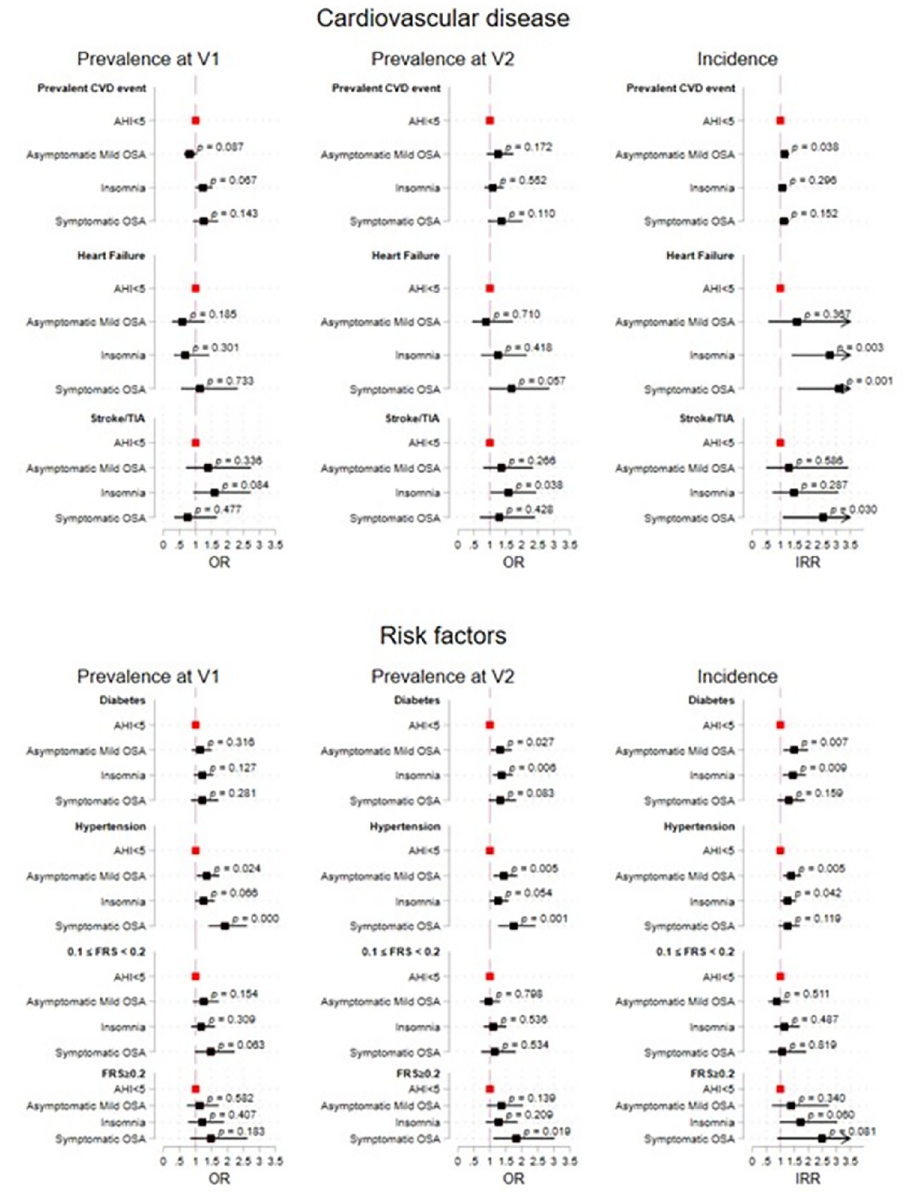
Fig 2. The estimated parameters and inferential statistics for the associations of OSA phenotypes with the cardiovascular disease and risk outcomes. AHI < 5 is the reference group. The prevalence at V1 models are adjusted for BMI, cigarette usage, alcohol usage, HDL cholesterol, total, cholesterol, and triglycerides all at V1. The prevalence at V2 models are adjusted for BMI, cigarette usage, alcohol usage, HDL cholesterol, total, cholesterol, and triglycerides all at V2. The incidence models are adjusted for BMI, cigarette usage, alcohol usage, HDL cholesterol, total, cholesterol, and triglycerides all at